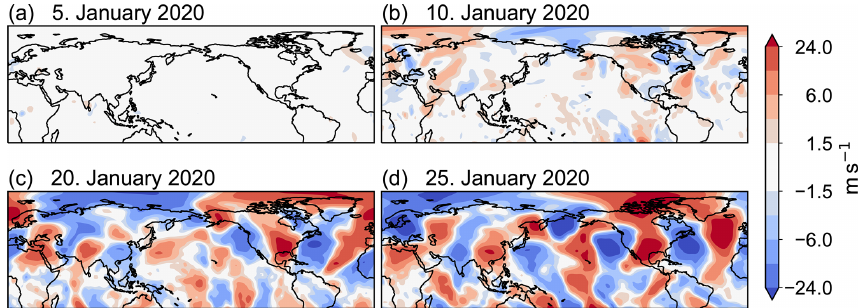
Figure 6. Spatial pattern of MPI-ESM1-2-LR anomalies in 250hPa meridional wind speed during January 2020 using a 5d centred, un- weighted rolling mean.